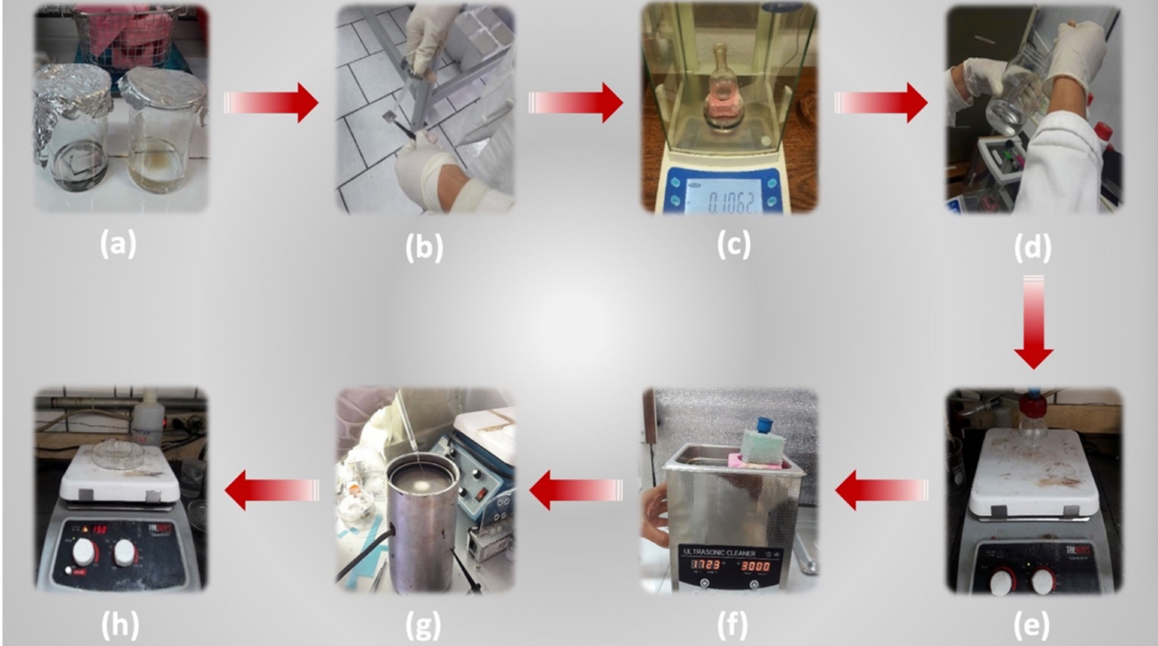
Figure 3. Images of the preparation procedure steps for the top and bottom films of the TEH: ( a ) substrates cleaning; ( b ) substrates drying; ( c ) samples weighing; ( d ) solution preparation; ( e ) magnetic stirring; ( f ) ultrasonic bathing; ( g ) spin coating; ( h )